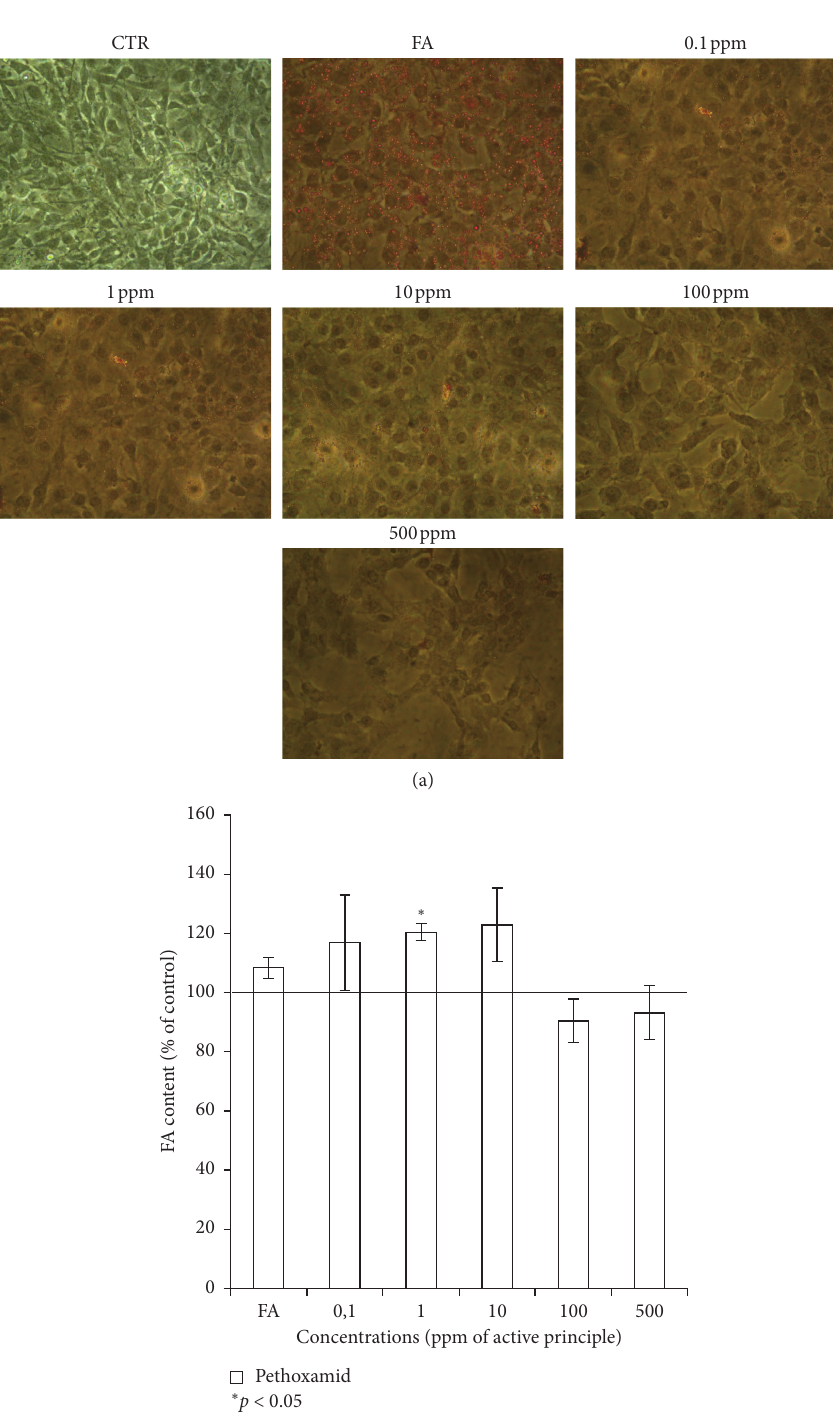
Figure 2: Oil red staining showed an increased steatosis at low-dose exposure. (a) Oil red O staining pictures for HepG2 cells in presence of fatty acids (FA) 6mM, and pethoxamid-treated cells at different concentrations (0.1–500ppm). (b) Spectophotometric quantification of lipid amount percentage with respect to the control of steatotic cells (FA 6 mM). ∗ P < 0 . 05 t -test analyses were performed to compare the significance of each treatment with respect to CTR. Values are means ± SD from three separate